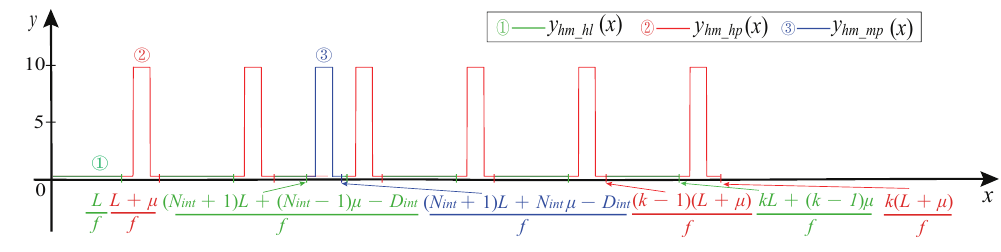
Figure 15. Hall CMP